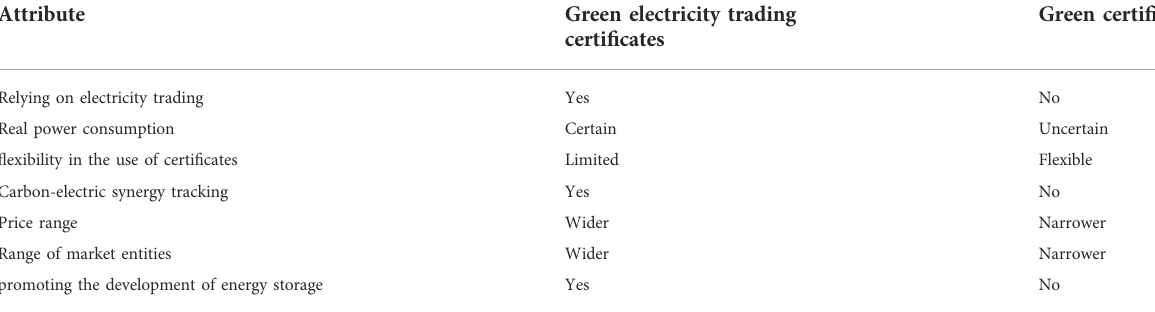
TABLE 1 Comparison of green electricity trading certi fi cates and green certi fi